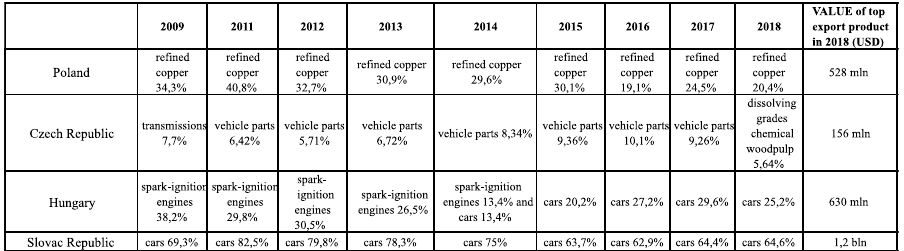
Top export product of V4 in years 2009–2018, % of export to China